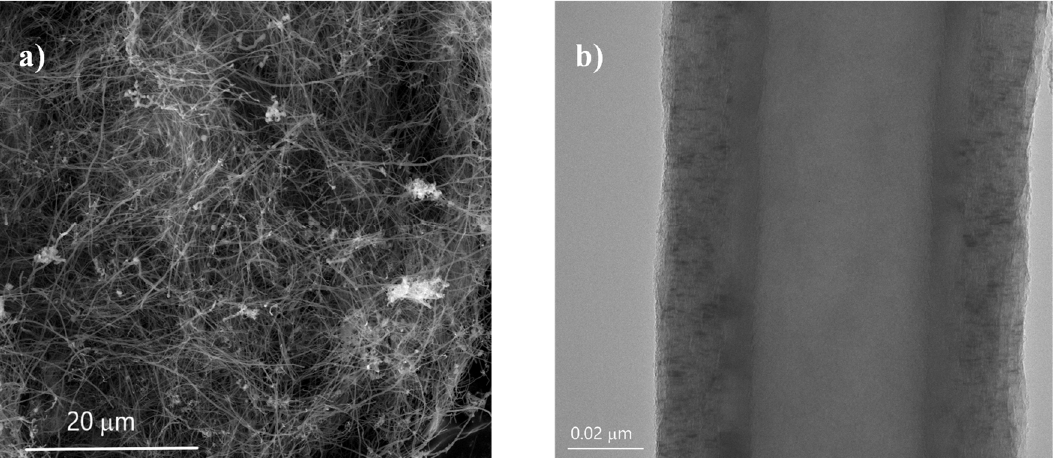
Figure 1. ( a ) SEM image of as-received carbon nanofiber powder, ( b ) TEM image of single CNF (Pyrograf ® III PR 24 LHT XT).